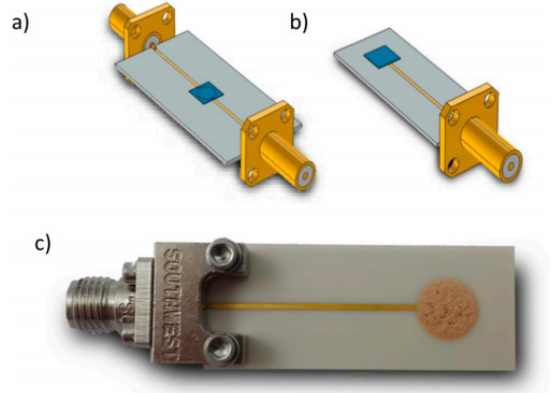
Figure 23. Three-dimensional sensor models with gas-sensitive cover layers; ( a ) types of transmission; ( b ) reflection resonator type; ( c ) fabricated microwave ring transducer [67].